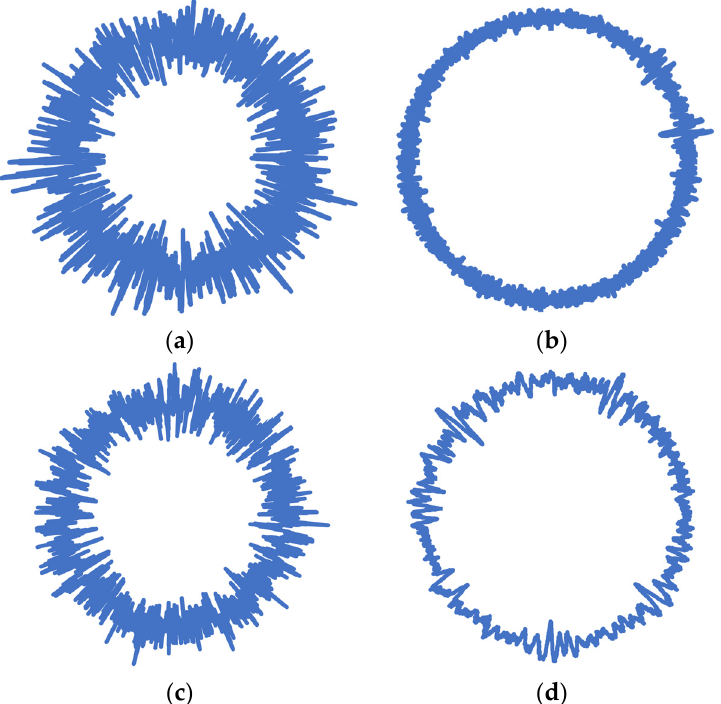
Figure 5. Sample radar plots representing each of the four air-filled pneumatic tire condition cases: